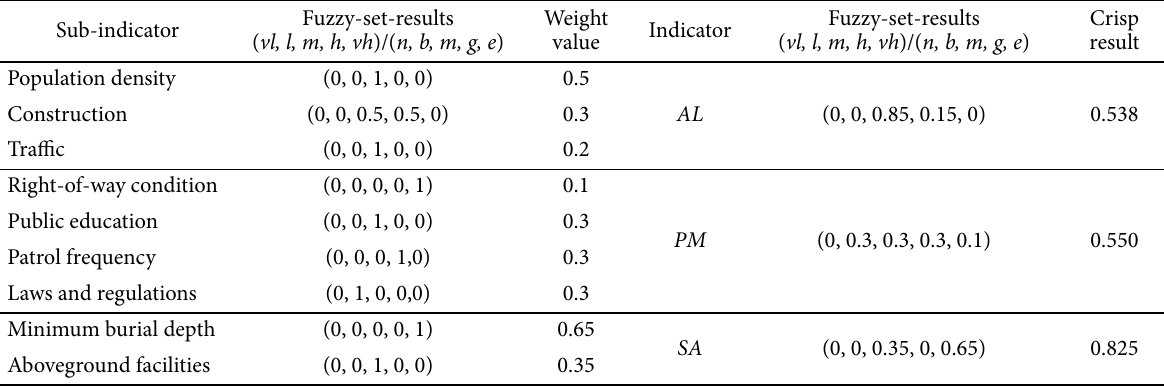
Table 2. The assessment results of sub-indicators and indicators for 8th pipeline section